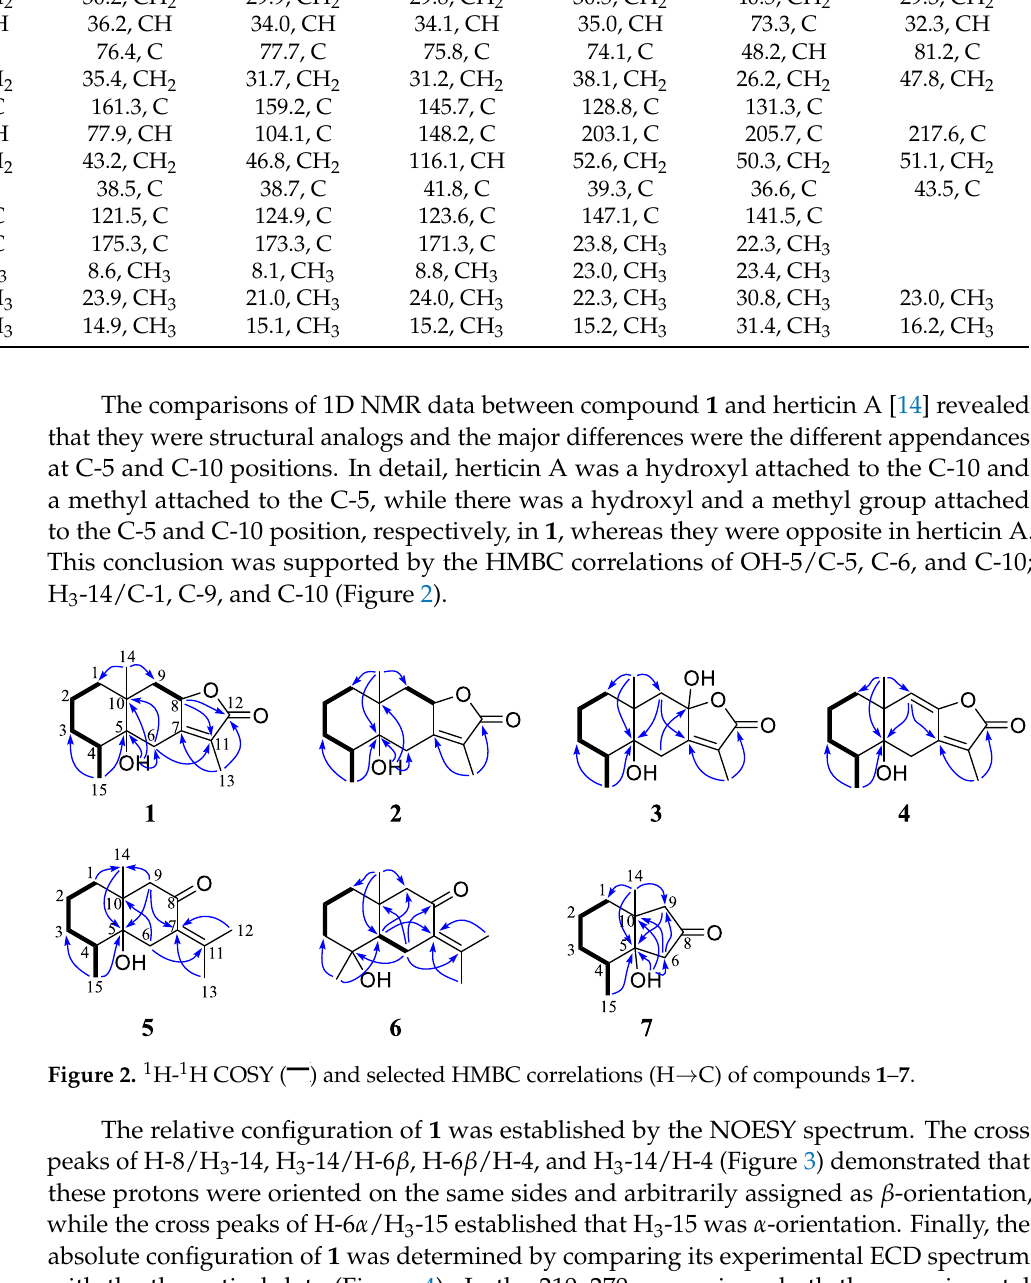
Table 2. 13 C (125 MHz) NMR data for compounds 1 – 7 in CDCl 3 ( δ in ppm).